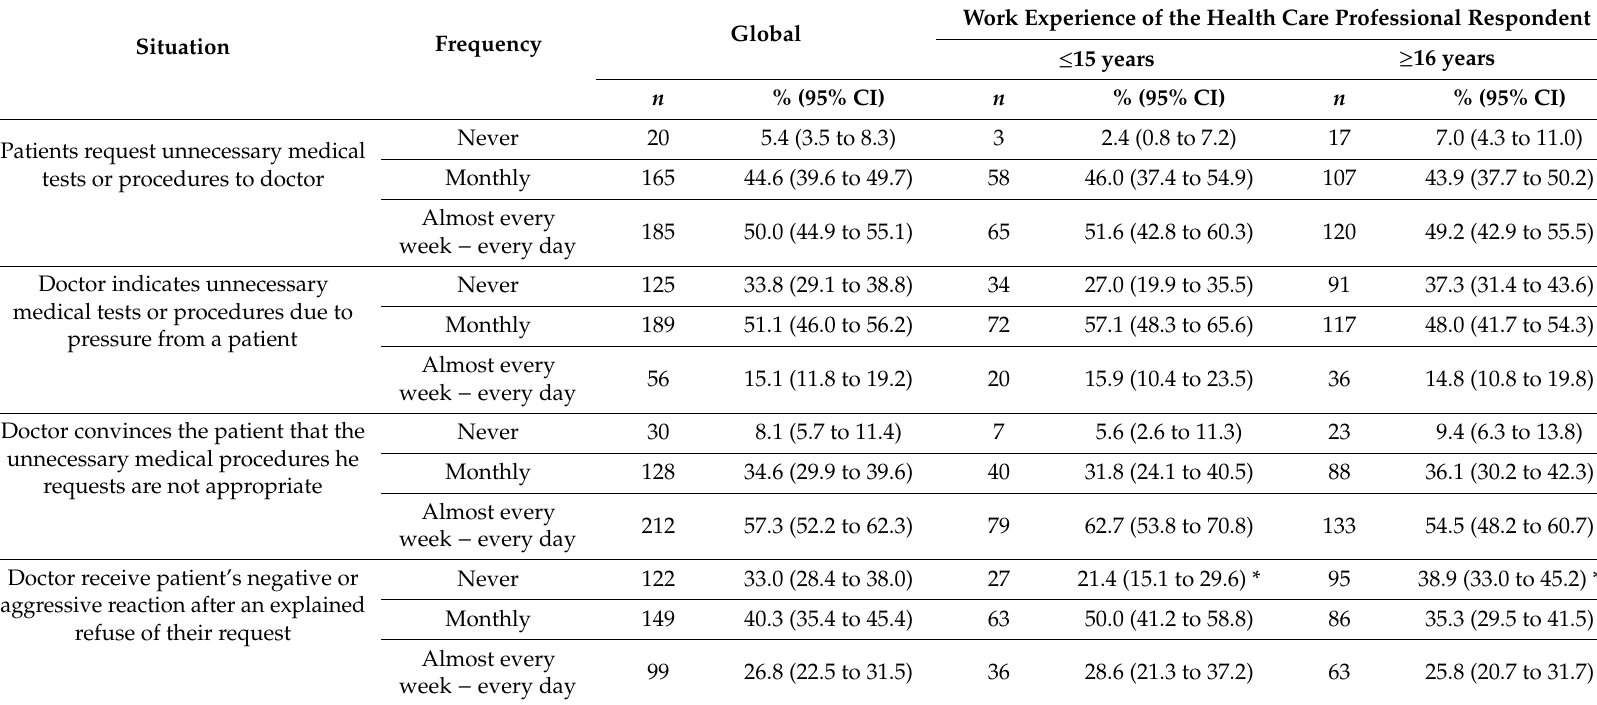
Table 1. Frequency of request and indication of unnecessary procedures by patients and